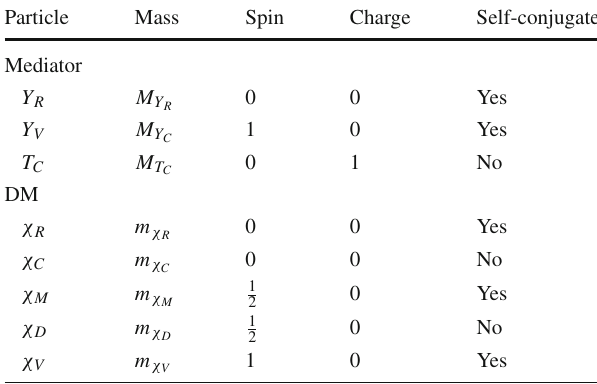
Table 1 Summary of mediators and DM candidates included in the simplified DM model considered